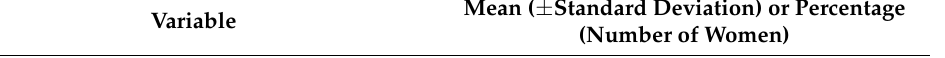
Table 2. Demographic data.